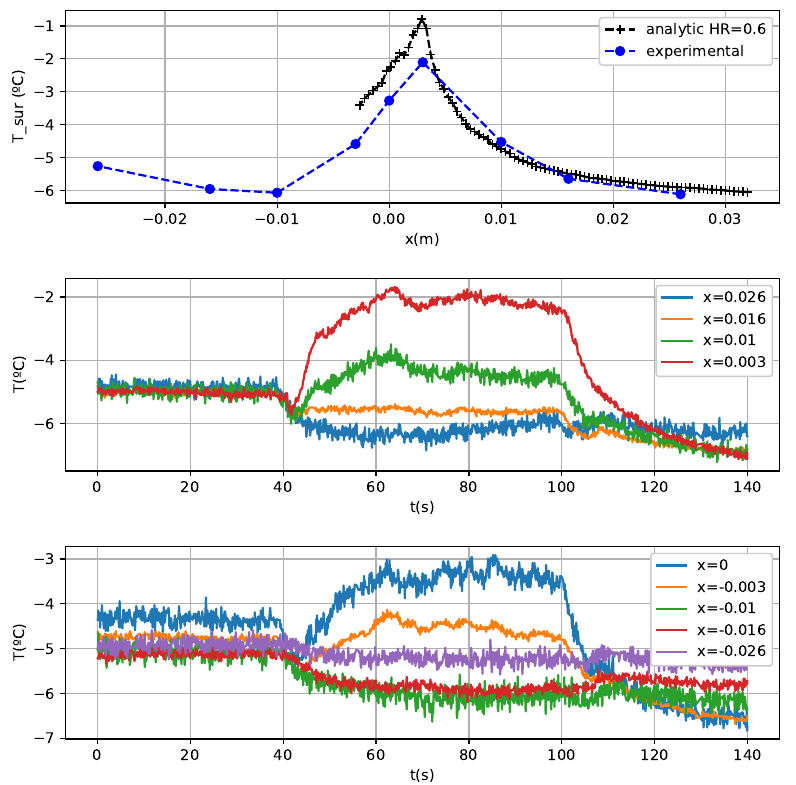
Figure 10. Test conditions: angle of attack: − 5 ◦ . V = 70 m/s. LWC = 0.39 g/m 3 . MVD = 20 µ